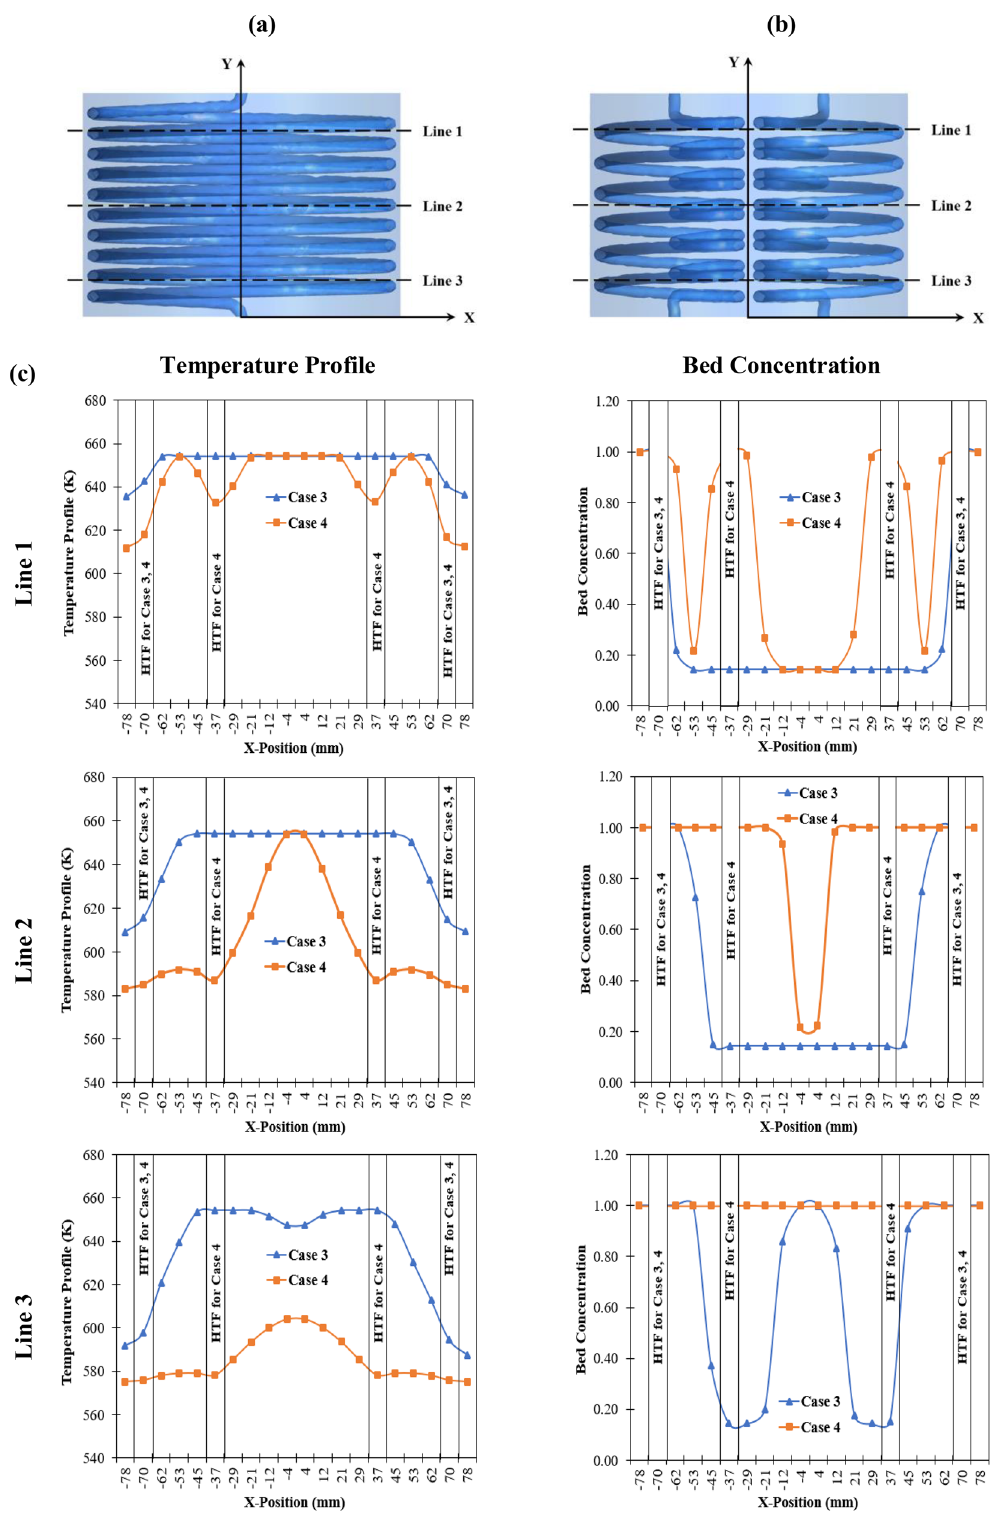
Figure 5. Temperature profiles and bed concentration at selected locations of the metal hydride reactor. ( a ) Selected locations for case 3, ( b ) selected locations for case 4, and ( c ) temperature profiles and bed concentration at selected locations after 20,000 s of hydrogen absorption process for case 3 and case